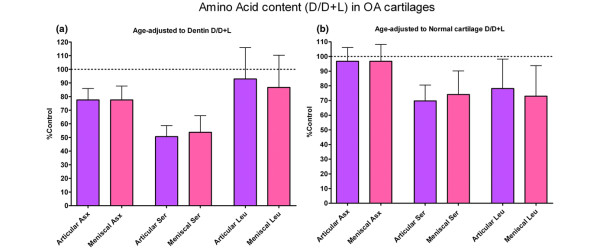
Age-adjusted D/D+L expressed as a percentage of the dentin control material and the normal articular cartilage control material. The paired t test comparing osteoarthritic (OA) articular cartilage with OA meniscal cartilage was not significant. The analysis of variance result for asparagine + aspartate (Asx), serine (Ser), and leucine (Leu) was P < 0.0001. The Bonferroni post test showed significant differences (P < 0.001) between all three amino acids (Asx, Ser, and Leu). (a) Dentin as control (mean percentage of control + standard deviation). (b) Normal articular cartilage as control (mean percentage of control + standard deviation). Purple represents OA articular cartilage, and pink represents OA meniscal cartilage.